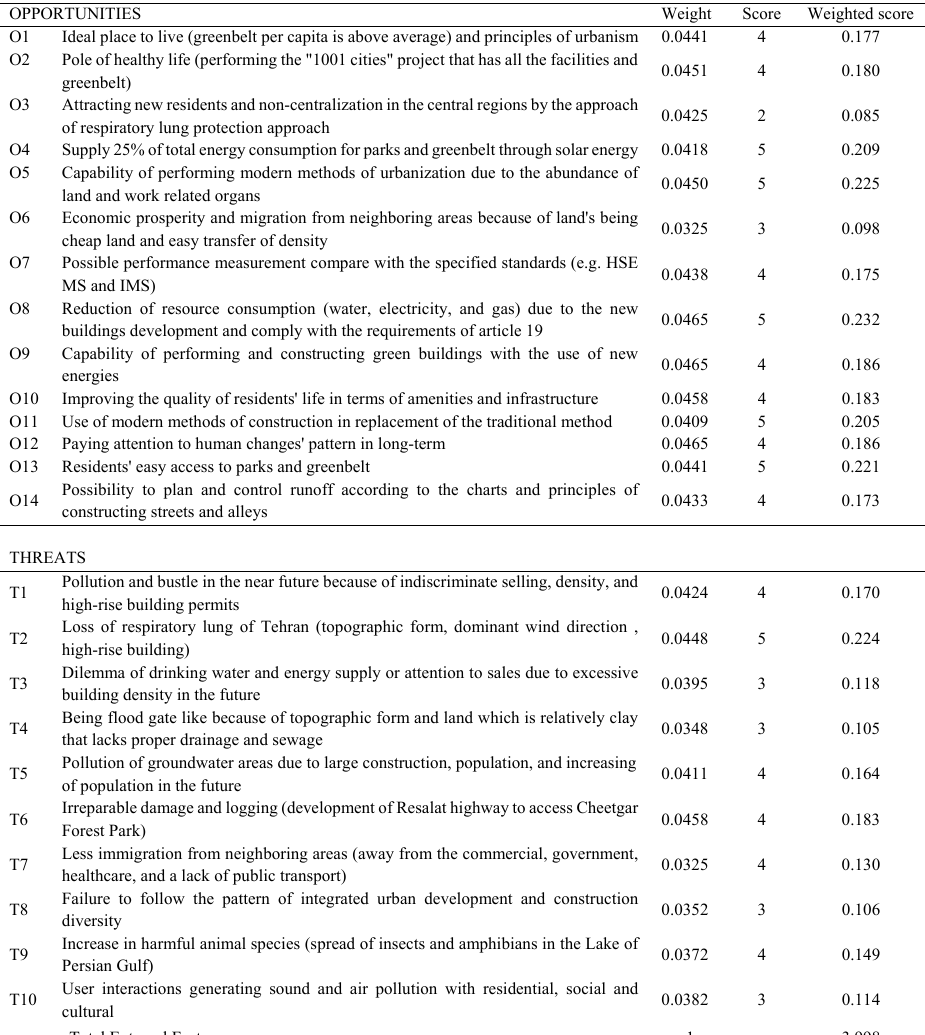
Table 3: External factor evaluation matrix